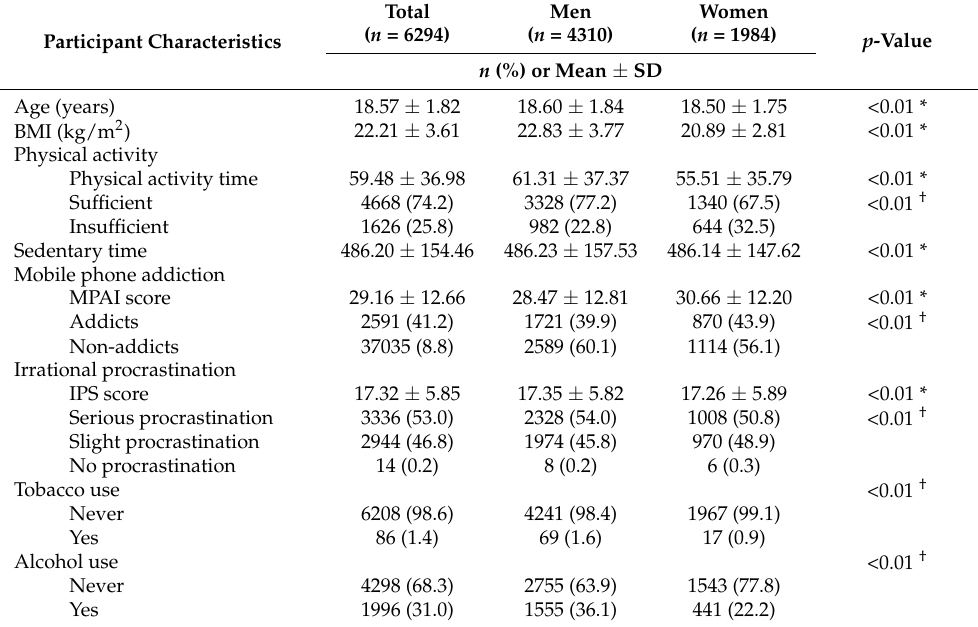
Table 1. Participants’ demographics and characteristics ( n =